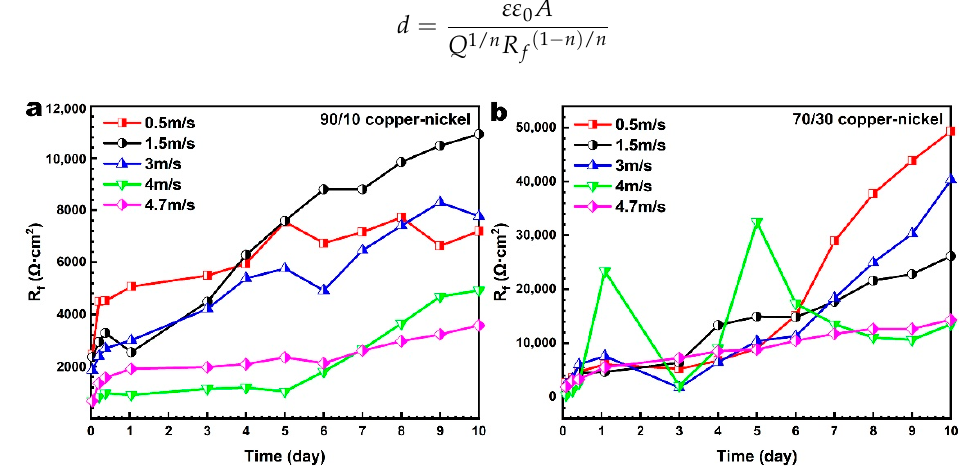
Figure 4. Evolution of the film resistance (R f = R f1 + R f2 ) collected from Tables 2 and 3 with erosion– corrosion time at different flow velocities for the 90/10 copper–nickel sample ( a ) and the 70/30 copper–nickel sample ( b ), respectively.